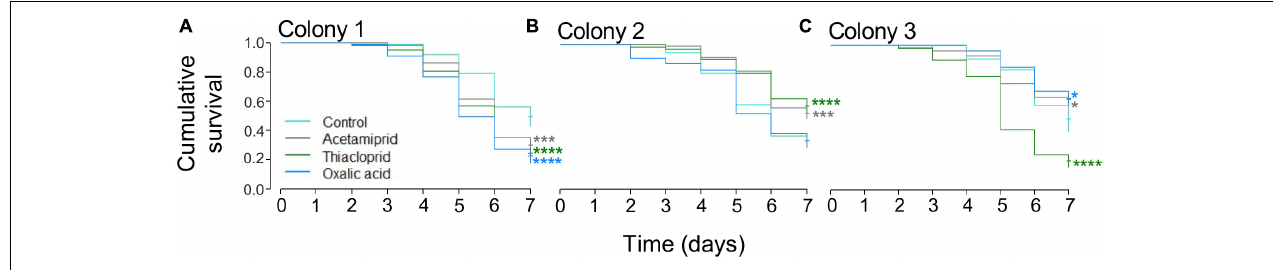
FIGURE 3 | Mortality across colonies and treatment in the in vivo caged bee experiment. (A) For colony 1, acetamiprid, thiacloprid, and oxalic acid reduced survival when compared to the control. (B) For colony 2, acetamiprid and thiacloprid increased survival when compared to the control. (C) For colony 3, both acetamiprid and oxalic acid increased survival, while oxalic acid increased mortality. * p < 0.05, *** p < 0.001, and **** p < 0.0001 ( Table 1 ).